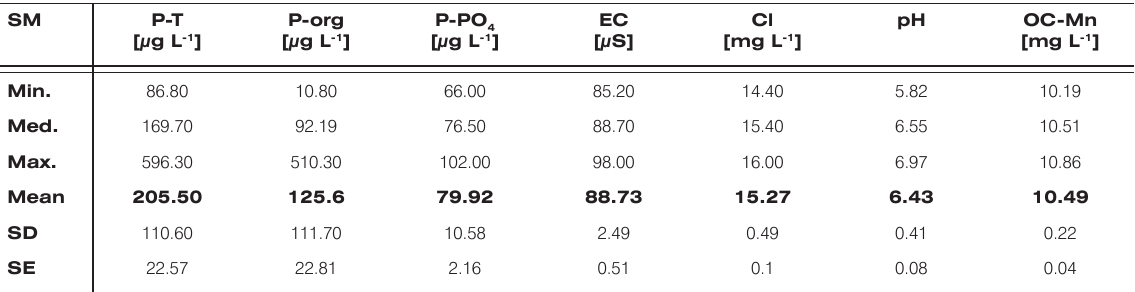
Table 3. Content of selected forms of phosphorus, chloride ions, conductivity, oxygen consumption (Mn) and pH in on surface microlayer taken by Garrett net. SM